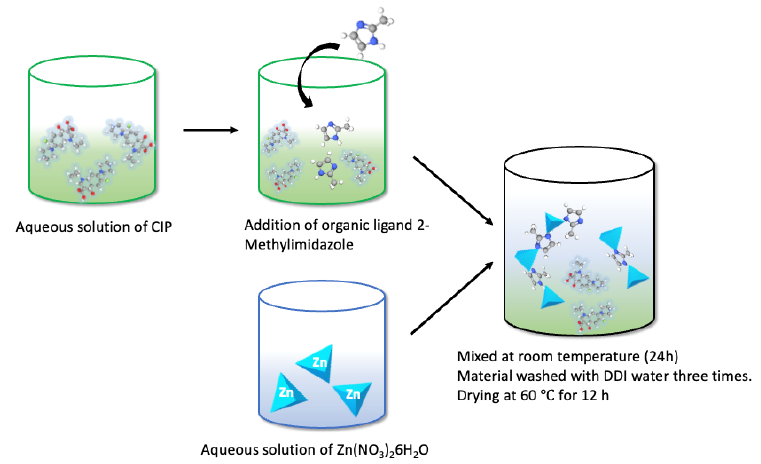
Figure 3. Outline of the in situ encapsulation of CIP in